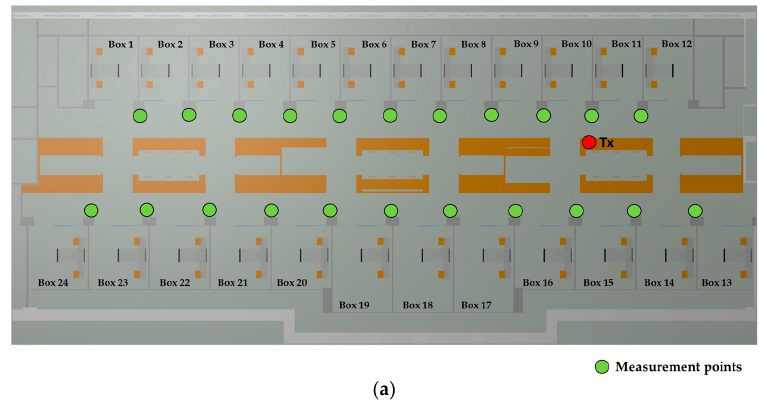
Figure 9. Measured spectrogram at 2.4 GHz band in the middle of the scenario with the XBee mote transmitting 10 dBm at ZigBee channel C (2.41